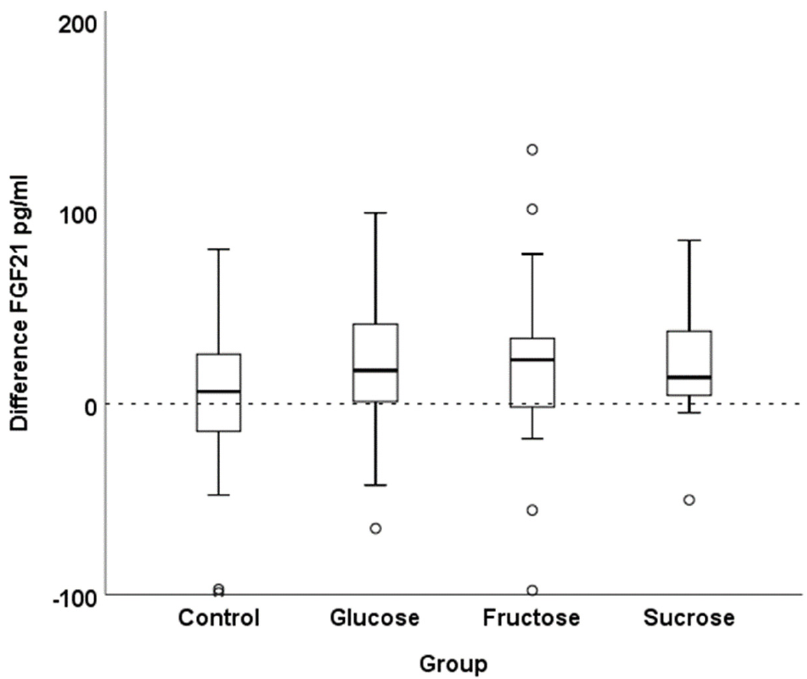
Figure 1. Difference in FGF21 concentrations between post-SSB intervention values or SSB abstinence values (control) (week 7), respectively, and baseline values (week 0) (boxplot with medians).